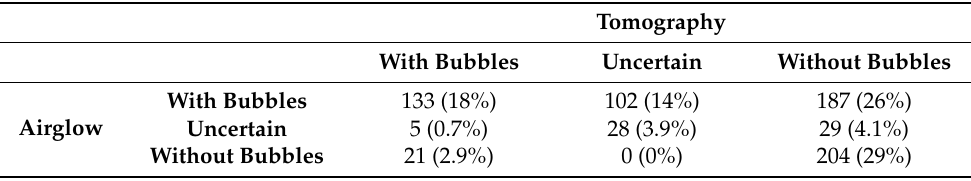
Table 2. Confusion matrix showing the number and percentage of plasma bubbles detected by the tomographic reconstruction and optical instruments in the observatory of São João do Cariri.